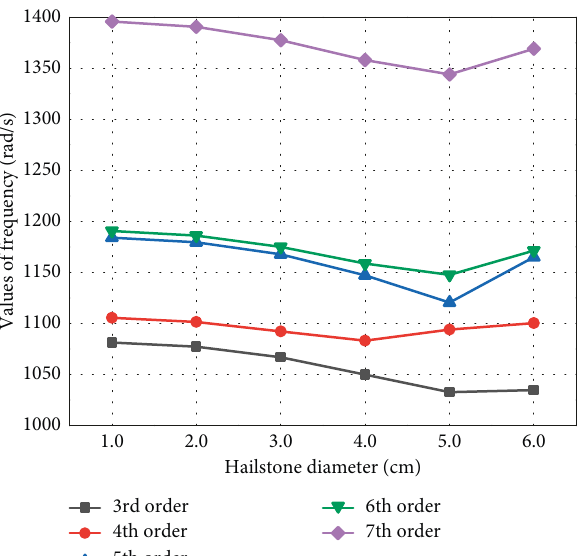
Figure 11: Frequencies (rad/s) under different hailstone diameters and time instants.